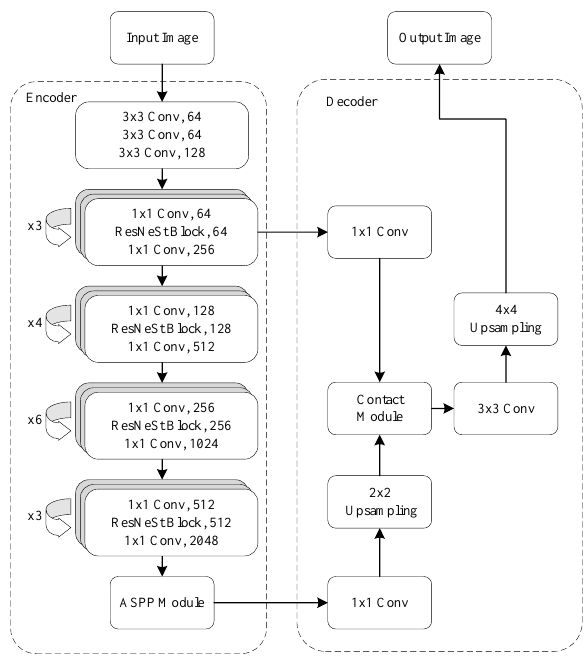
Figure 5 . Deeplabv3+ with ResNeSt